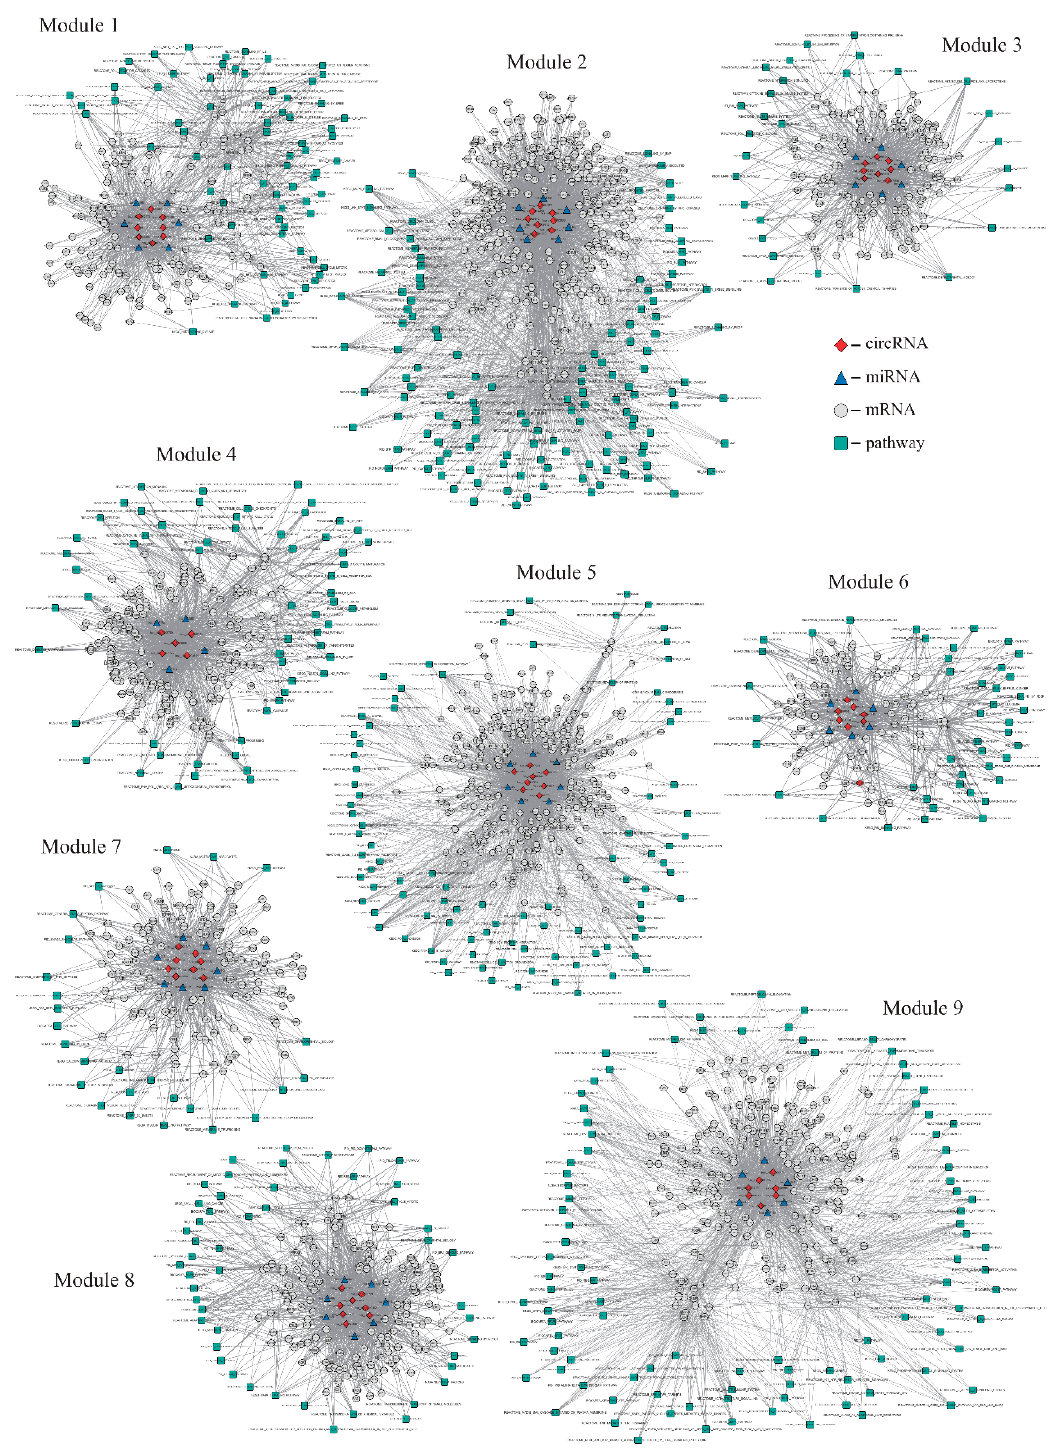
Figure 2. The overview of nine circRNA functional modules, including 1174 mRNAs, 44 circRNAs, 30 miRNAs and 325 pathways.